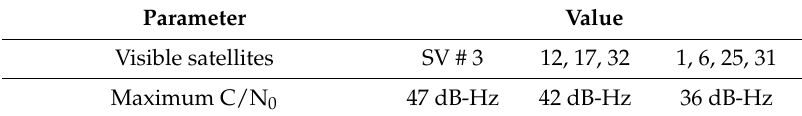
Table 4. The parameters of the set of static data.